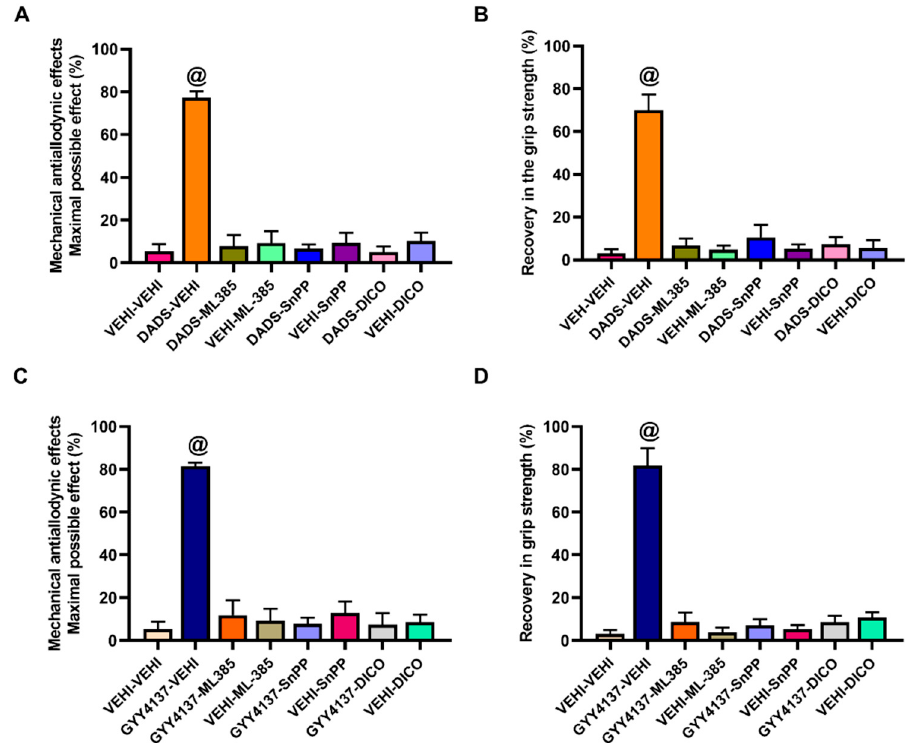
Figure 4. Effects of the co-administration of DADS and GYY4137 with vehicle, ML-385, SnPP or dicoumarol in the mechanical allodynia and loss of grip strength caused by MIA. The antiallodynic ( A , C ) and the recovery of grip strength ( B , D ) induced by DADS (30 mg/kg) or GYY4137 (6 mg/kg) combined with 25 mg/kg of ML-385 or 10 mg/kg of SnPP or dicoumarol (DICO) are shown. The effects produced by each of these treatments administered alone are also represented. For each treatment and test assessed, @ denotes significant differences vs. the other groups ( p < 0.05, one-way ANOVA; Student–Newman–Keuls test). Data are expressed as mean values of the maximal possible effect (%) for the mechanical allodynia and the recovery of grip strength (%) ± SEM; n = 6 animals per dose and